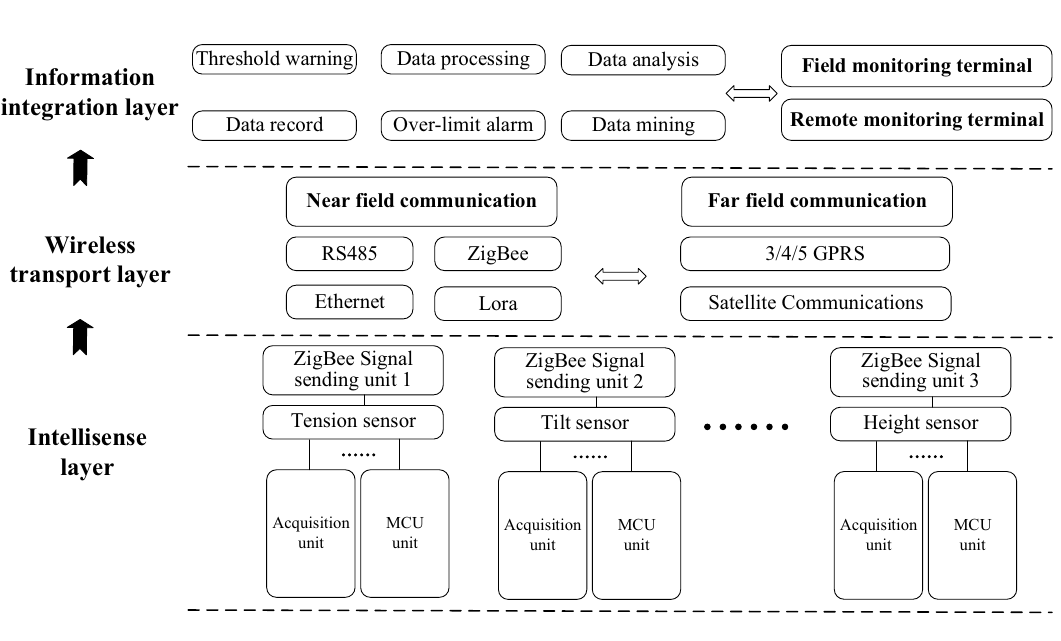
Figure 2. Overall structure diagram of the